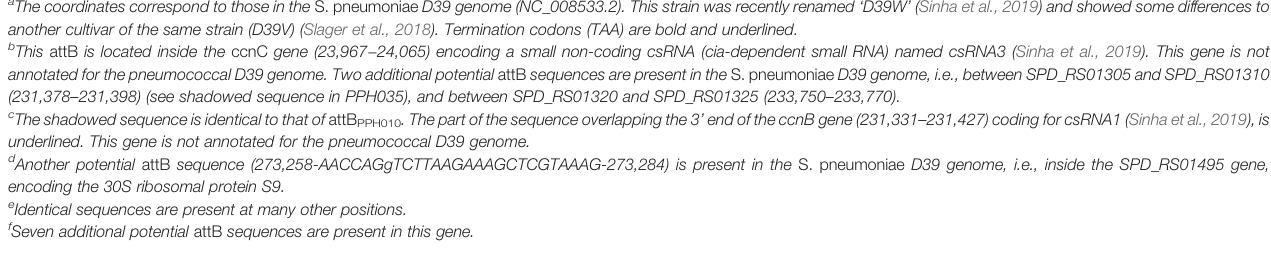
Table S6 attempts to organize the different PPHs in a manner that takes into account their wide genetic diversity. For this, a